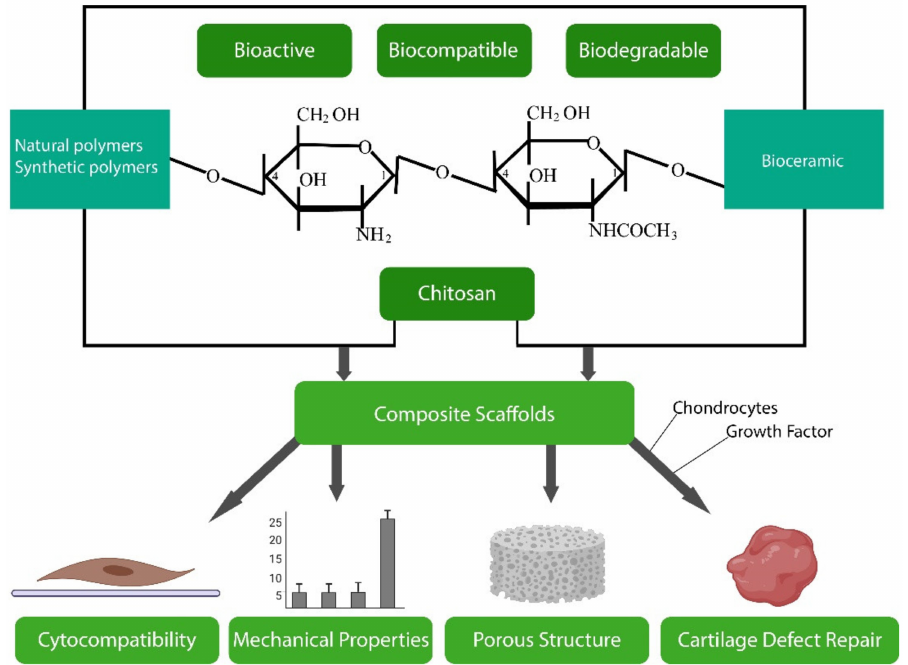
Figure 6. Composition of the chitosan polymer and examples of properties that influence its biomed- ical uses (based on